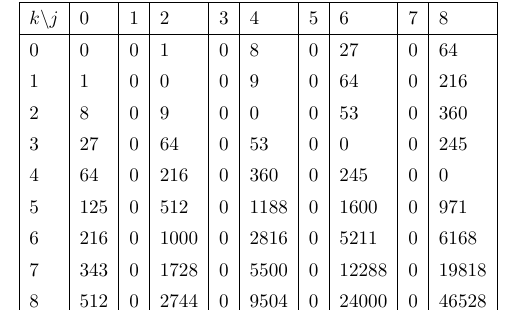
Table 63. Table of b jk coe(cid:14)cients for h SU(3)